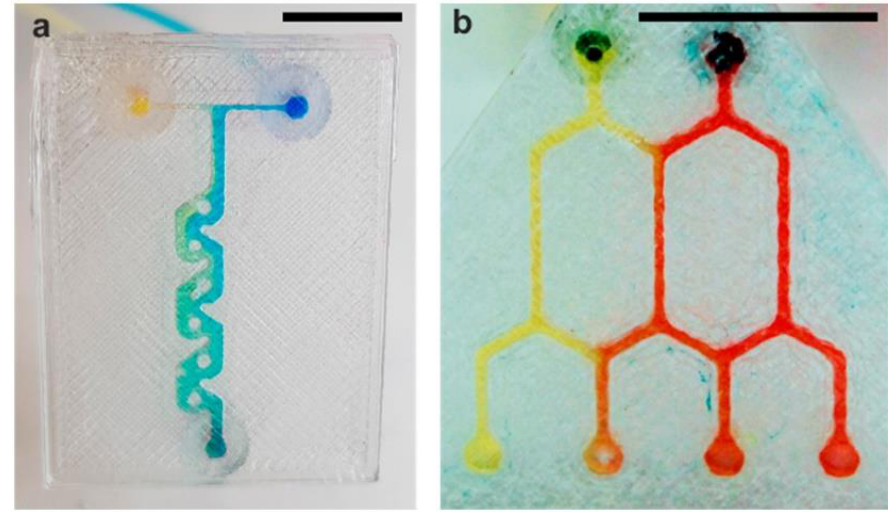
Figure 4. FDM printed microfluidic devices by Mader et al. [88]: ( a ) representation of Tesla-like micromixer; and ( b ) representation of cascade mixer.